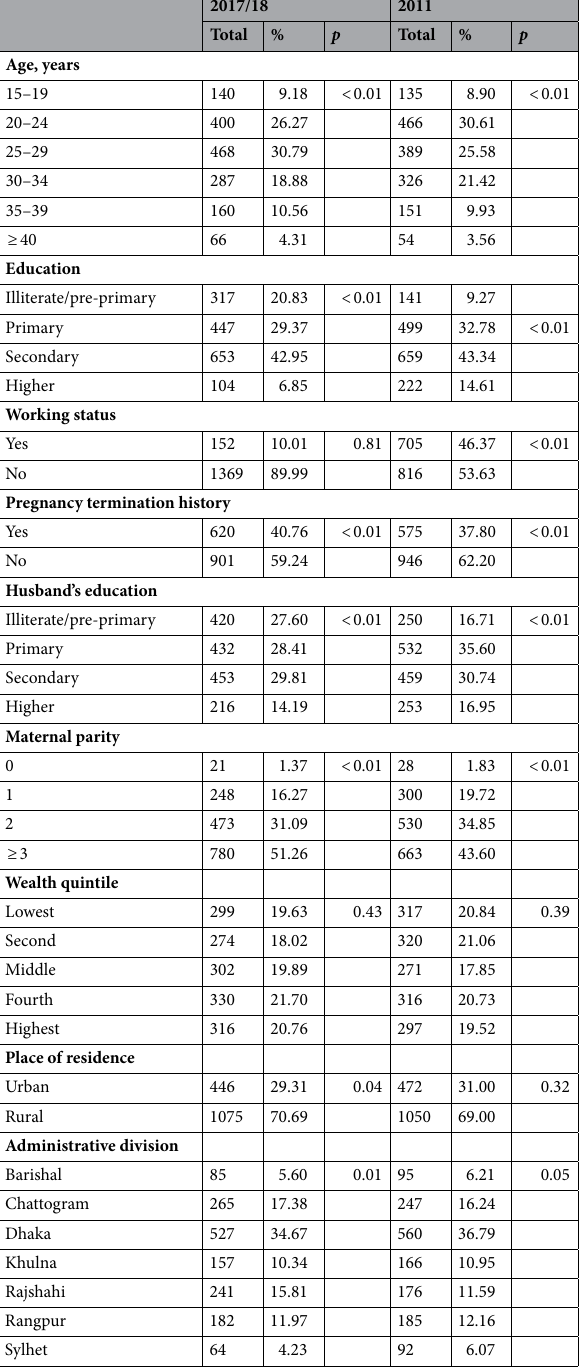
Table 3. Distribution across demographic characteristics of women who experienced contraceptives